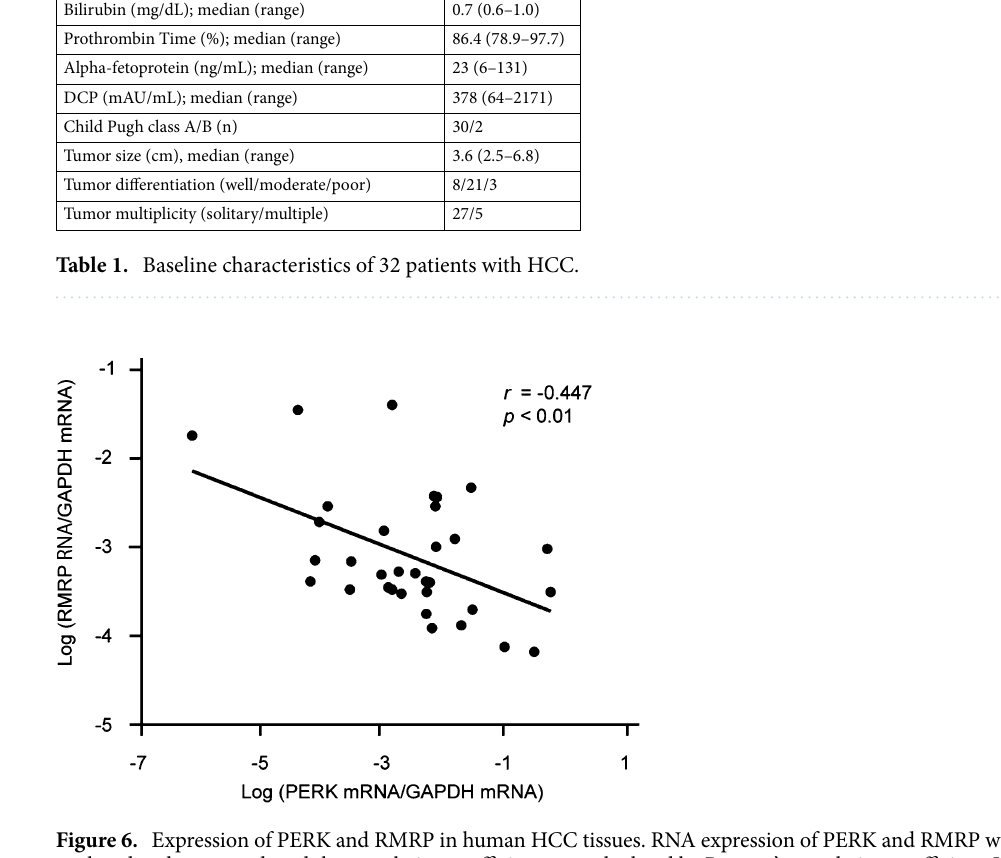
Figure 6. Expression of PERK and RMRP in human HCC tissues. RNA expression of PERK and RMRP was analyzed and compared, and the correlation coefficient was calculated by Pearson’s correlation coefficient. We found a negative correlation between PERK and RMRP expression in HCC specimens with real-time